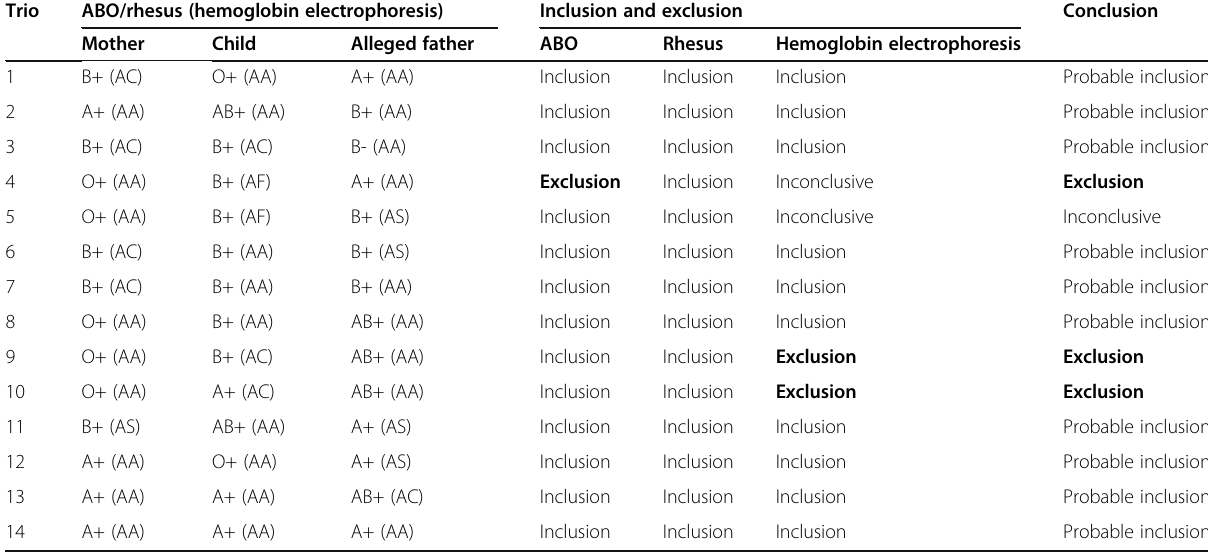
Table 2 Inclusion and exclusion results according to the ABO-rhesus/hemoglobin electrophoresis Trio ABO/rhesus (hemoglobin